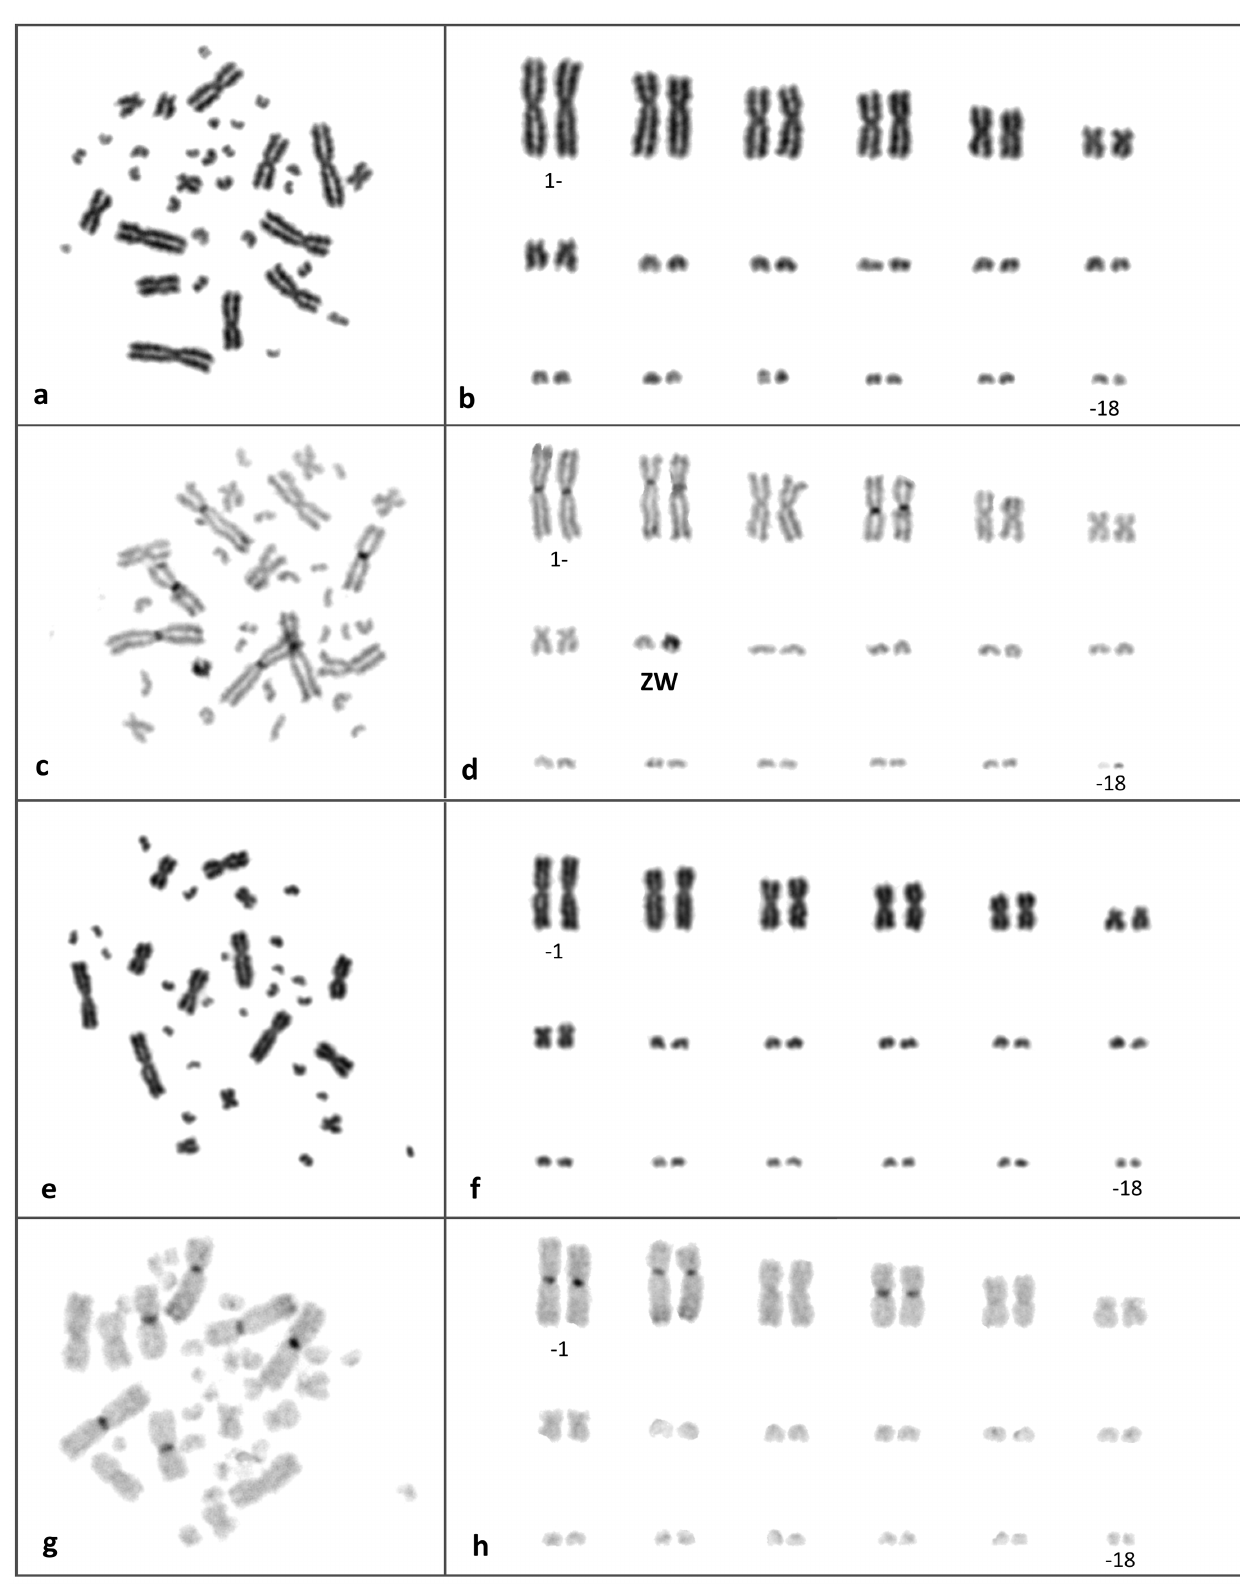
Figure 2. Giemsa (a, b, e, f) and C-banded (c, d, g, h) metaphase chromosomes and karyotypes from a female (a–d) and a male (e–h) of Helodermasuspectum . The sex chromosomes are labelled in the C-banded female karyotype (d).